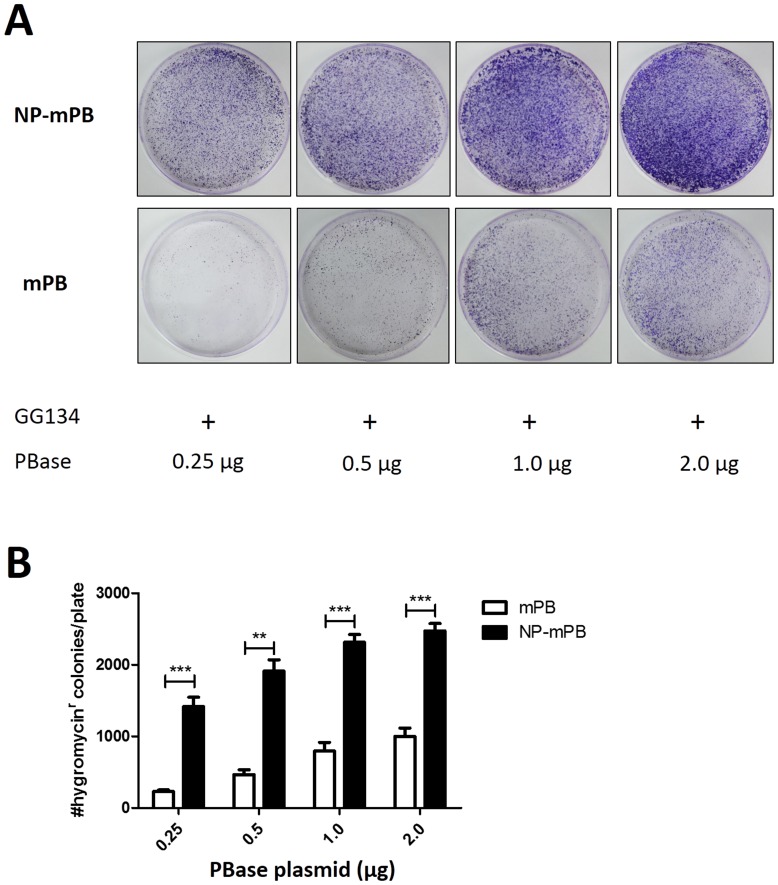
Evaluation of the transposition efficiency mediated by the gradient concentrations of PBase.(A) The NP-mPB group demonstrated more colonies compared to the mPB group in HEK293T cells transfected with varying amounts of plasmid DNA. (B) Colony numbers were quantified, revealing a 2.5- to 6-fold increase in transposon integration efficiency for NP-mPB. The transposition efficiency was higher when more plasmid was transfected for both groups. No overproduction inhibition was noted. n  = 3 for each condition; bars indicate mean ± standard error; ** P<0.01, *** P<0.001.